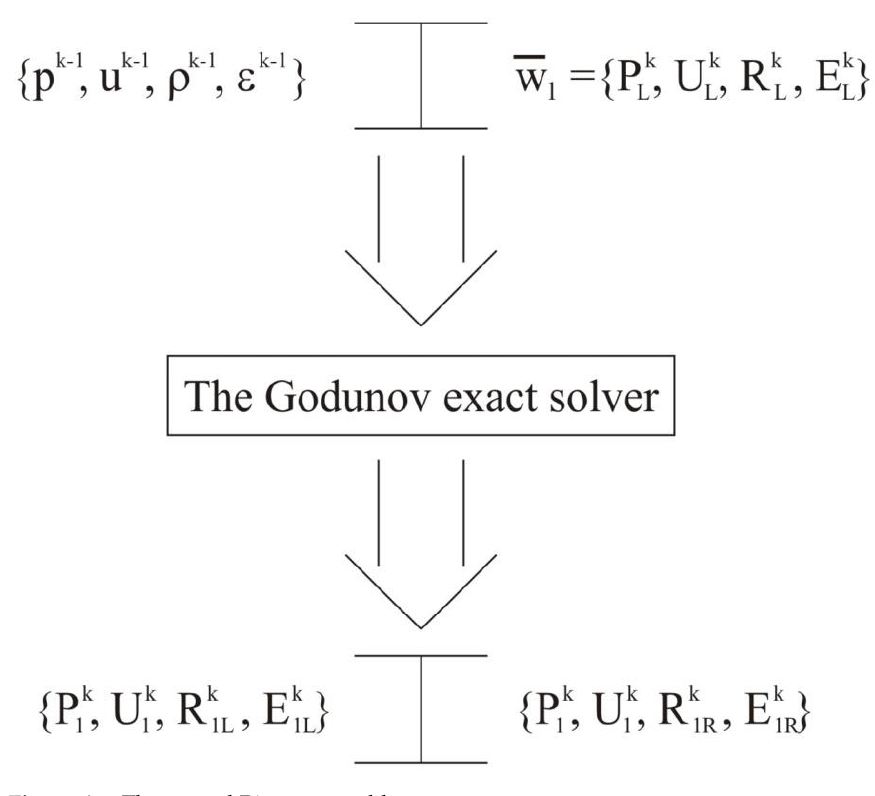
Figure A3. The second Riemann problem.